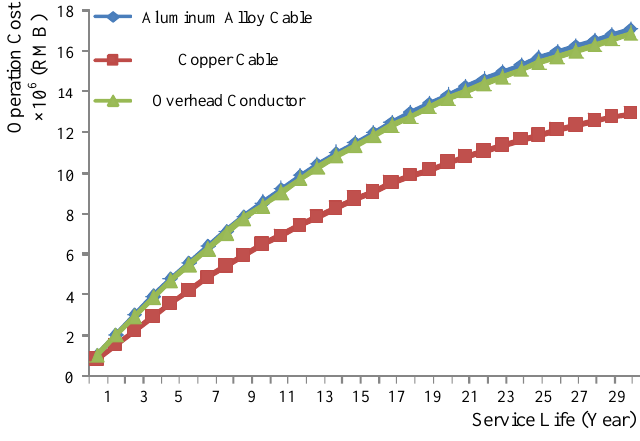
Figure 14. Operation and maintenance cost during 30 years in Case 2.